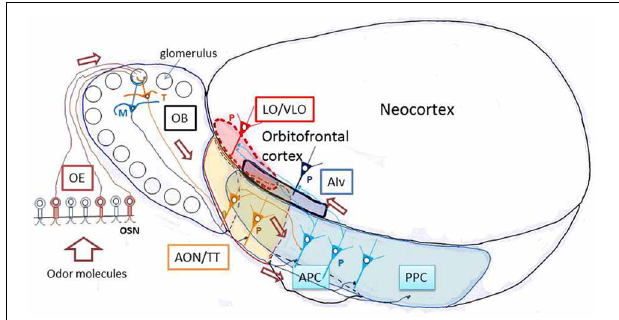
FIGURE 1 | Olfactory pathways to the orbitofrontal cortex in rodents. A schematic diagram of the lateral view of the rodent brain illustrating the neuronal pathways from olfactory sensory neurons through the olfactory bulb and olfactory cortex to the orbitofrontal cortex. AIv, ventral agranular insular cortex; AON, anterior olfactory nucleus; APC, anterior piriform cortex; LO, lateral orbital cortex; M, mitral cell; OB, olfactory bulb; OE, olfactory epithelium; OSN, olfactory sensory neuron; P, pyramidal cell; PPC, posterior piriform cortex; T, tufted cell; TT, tenia tecta; VLO, ventrolateral orbital cortex. The orbitofrontal cortex (LO/VLO) is surrounded by red broken